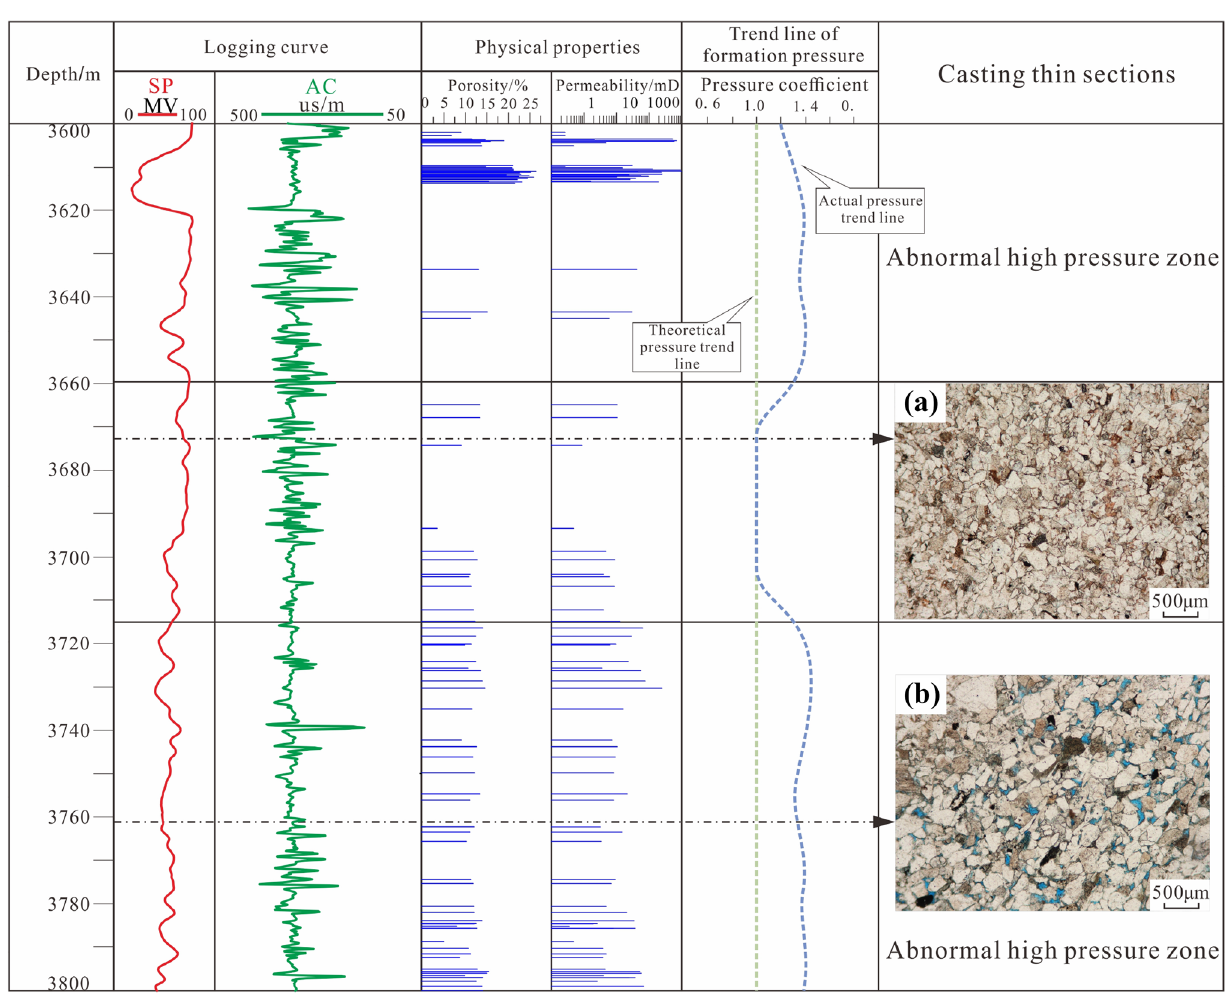
Fig. 6 Relationship between formation pressure and reservoir physi- cal properties of well L101 in the Dawangzhuang area of the Raoyang sag ( a : Well L101, 3672.53 m, abnormally high-pressure underdevel- oped area, with strong compaction and almost loss of primary pores;